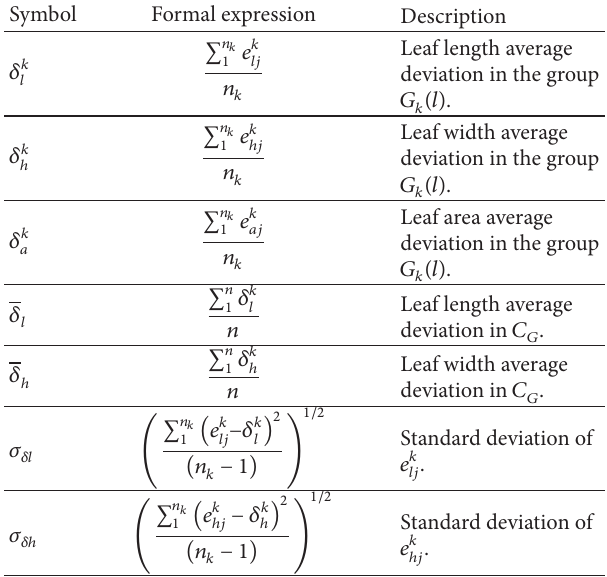
Table 4: Estimation errors for observed and image obtained variables averages and standard